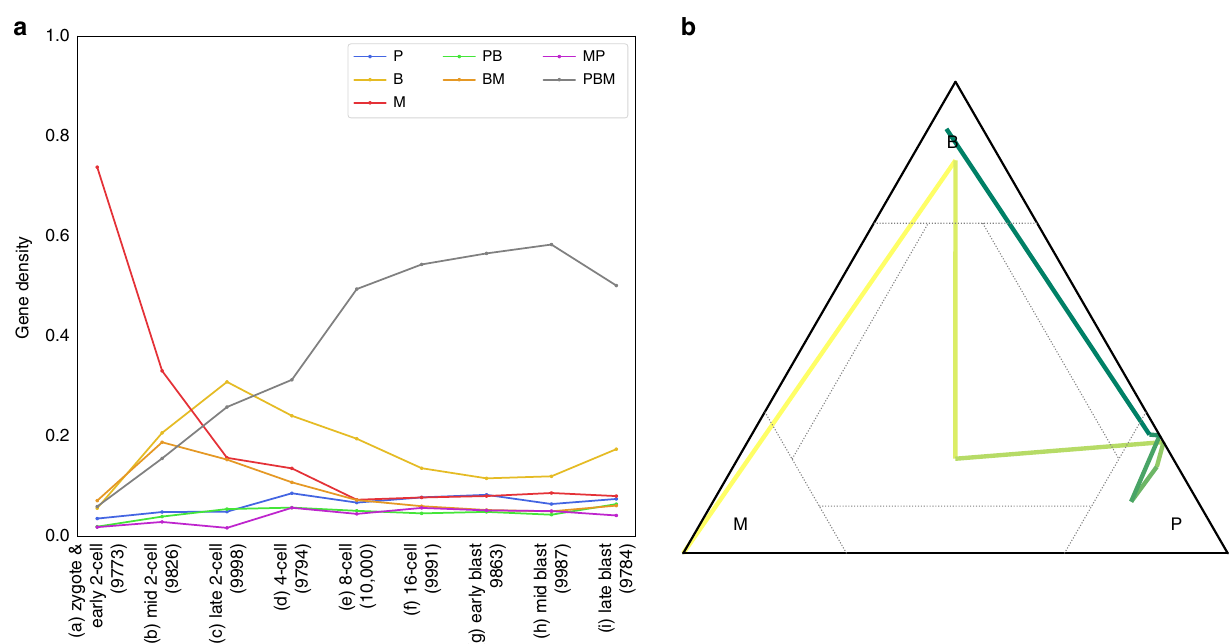
Fig. 7 Dynamics of allele-speci fi c expression patterns along the embryo development. a Cells were divided into nine developmental stages as indicated on the X -axis. The cell types and numbers of expressed genes at each stage are indicated in parentheses on the X -axis. For each stage, we counted the proportion of expressed genes that fall into each of the seven allelic expression patterns ( Y -axis), indicated by lines using the same color coding used in Fig. 6. In the zygote and early 2-cell stage, most genes show purely maternal expression ( M ). The proportion of maternally expressed genes decreases through subsequent stages of development. The numbers of genes showing purely paternal expression ( P ) is low across all developmental stages. The M and P classes become equally represented in the later stages of development. The 2- and 4-cell stages show high levels of bi-allelic expression ( B ) and the mixed class ( PBM ) proportion becomes highest by the 8-cell stage. b The expected proportions of cells in each allelic state ( π s each stage of the developmental time course is shown as a trajectory in the 3D simplex. Yellow to blue color line segments indicates the transitions between developmental stages. This gene starts in the maternal monoallelic state ( M ), it transitions through PBM to a paternal expression state ( P ), and then transitions to bi-allelic expression ( B ) in the blastocyst